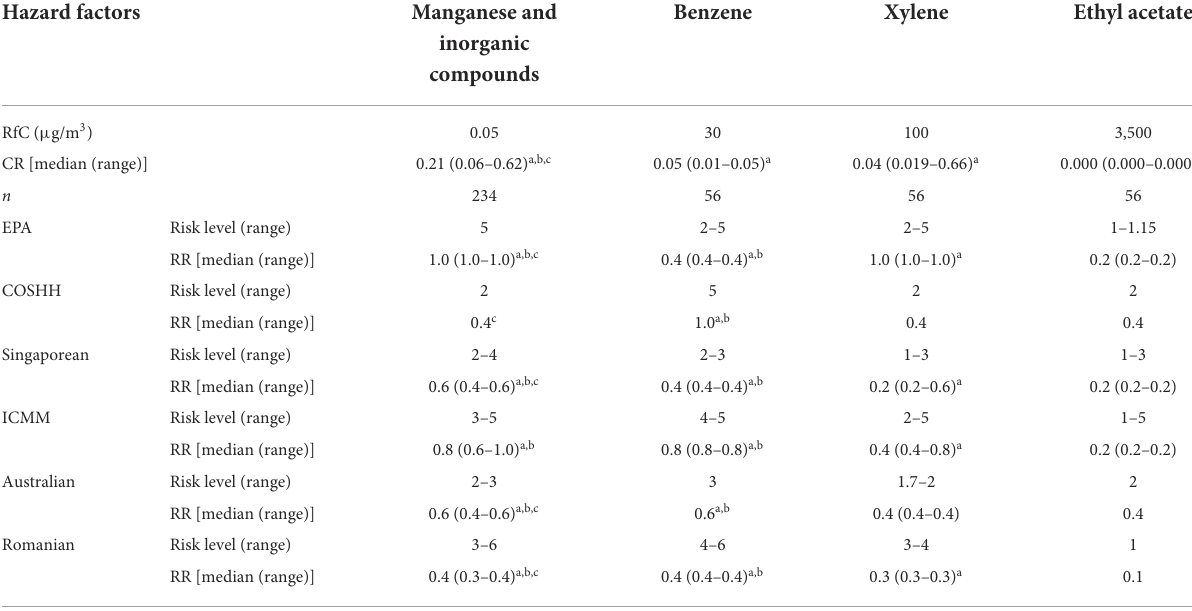
TABLE 3 Quantitative comparison of RRs among the six OHRA models for four hazard factors.